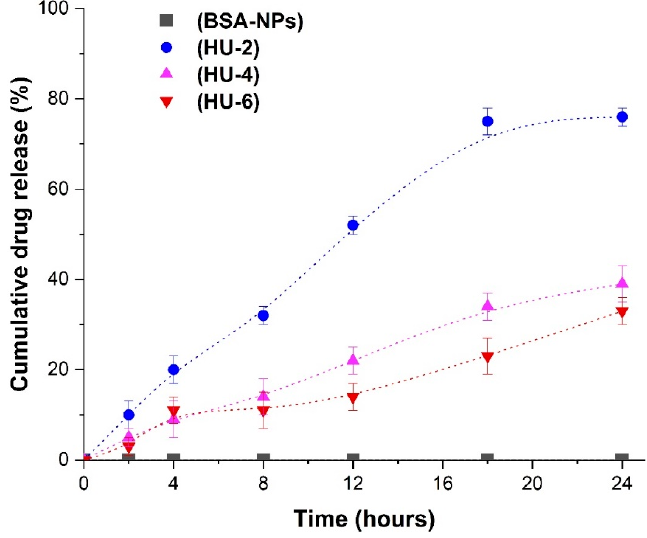
Figure 8. Release of hydroxyurea (HU) from different types of nanoparticles. Data are presented as mean ± SD (n = 3). mean ± SD (n =